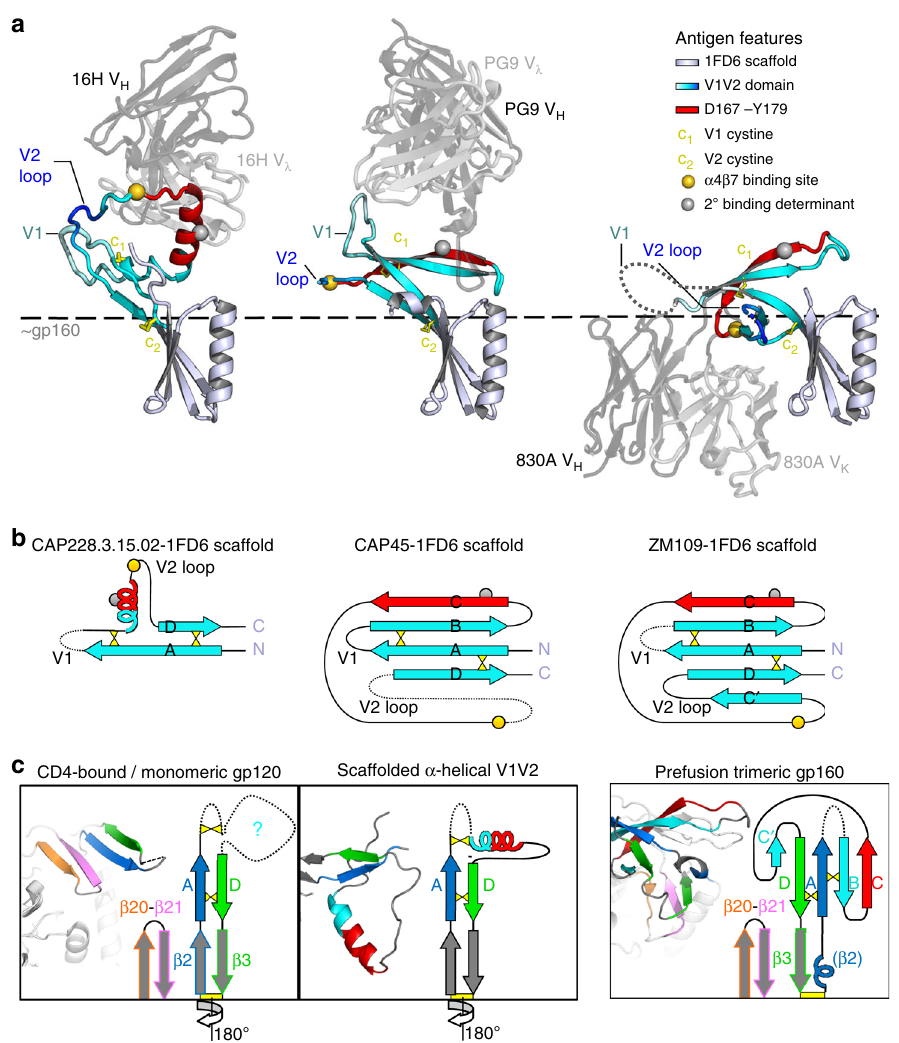
Fig. 5 Comparisons of the V1V2 domain when bound by V2p, V2q and V2i mAbs. a A cartoon representation of CAP228-16H (V2p, left), PG9 (V2q, middle) and 830 A (V2i, right) bound to 1FD6 scaffolded V1V2. Only the Fab variable domains are shown for clarity, with the heavy and light chains coloured dark and light washed-out grey, respectively. All three structures are oriented with respect to the 1FD6 scaffold (metallic blue). Residues 167 – 179 that make up the V1V2 C-strand, or the IGHV5-51 bound α -helix, are shown in bright red, with the remaining V1V2 regions coloured as in Fig. 4. The V1V2 internal disulphide bonds are shown with yellow sticks, and α 4 β 7 binding determinants are labelled with gold and silver spheres. A dashed line was used to indicate the approximate location for the rest of gp160 relative to full length V1V2. b Schematic of the V1V2 domain, showing the relative refolding of B- and C-strands, and repositioning of the A- and D-strands between the α -helical and β -stranded conformations of V1V2. The α 4 β 7 binding determinants and disulphide bonds are labelled as in a . c Cartoon views and schematic representations of V1V2 in the CD4-bound or monomeric gp160 state (left panel), the V2p-bound α -helical state (middle panel), and the prefusion, entry-competent gp160 trimer (right panel). The β 20 and β 21 strands that make up one half of the bridging sheet are coloured orange and pink, respectively. The β 2 strand of gp120 (or overlapping prefusion associated α -helical structure), and subsequent V1V2 A-strand region is coloured dark blue, while the V1V2 D-strand and subsequent β 3 strand of gp120 is coloured green. The remaining V1V2 region is coloured as in